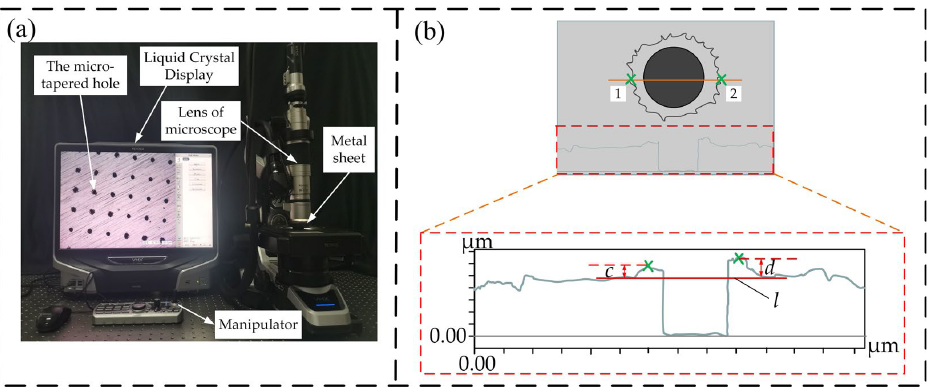
Figure 3. Picture of ultra-depth-of-field 3D microscopic measurement: ( a ) Microscope measurement object diagram; ( b ) Schematic of enlarging the burr height of the metal sheet.